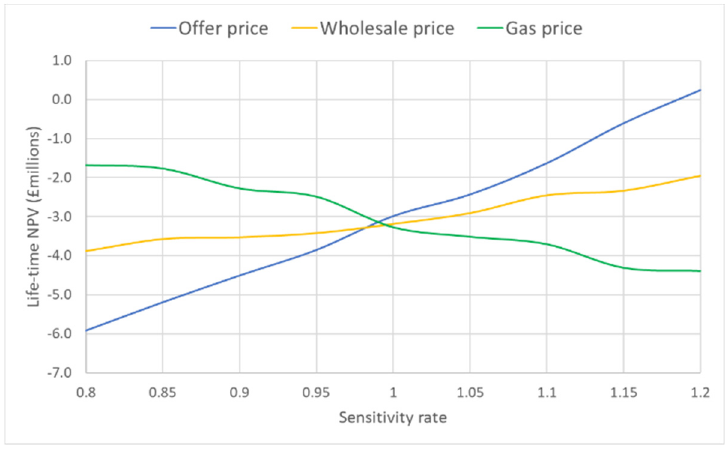
Figure 13. Assessing NPV sensitivity on o ff er, wholesale and gas prices for 5 MWh / 19MW, LT technology, Figure 13 . Assessing NPV sensitivity on offer, wholesale and gas prices for 5 MWh/19MW, LT 7 cycles / day, at 8% discount technology, 7 cycles/day, at 8% discount rate.